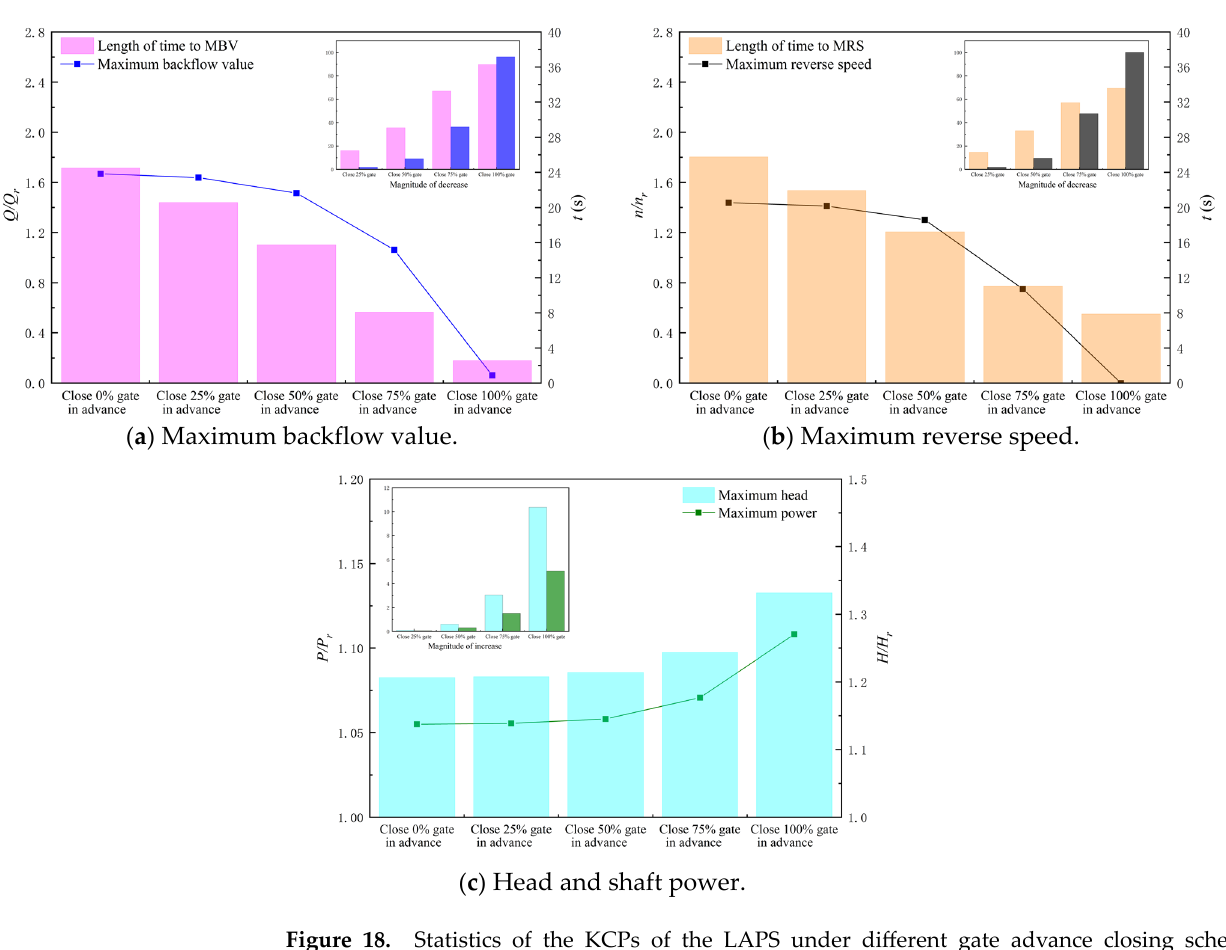
Figure 18. Statistics of the KCPs of the LAPS under different gate advance closing schemes (TTGC: 60 s).